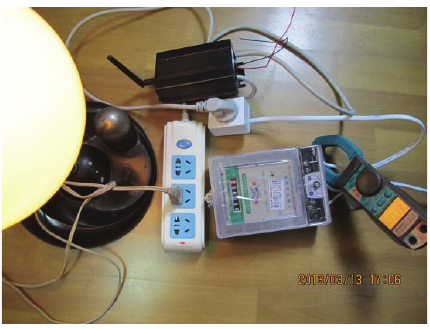
Figure 12: ZBEMCS, standard wattmeter, and clamp